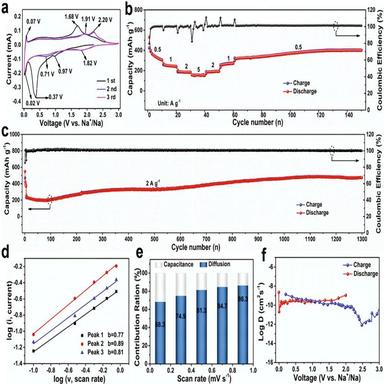
Electrochemical performances of 1 T-MoS2/MoOx@NC for SIBs: (a) CV curves, (b) rate capability at different current densities, (c) cycling performance at a high current density of 2 A g− 1 , (d) relationship between log i and log ν of cathodic and anodic peaks, (e) rates of capacitive contribution, and (f) Na-ion diffusion coefficient for charge and discharge process.